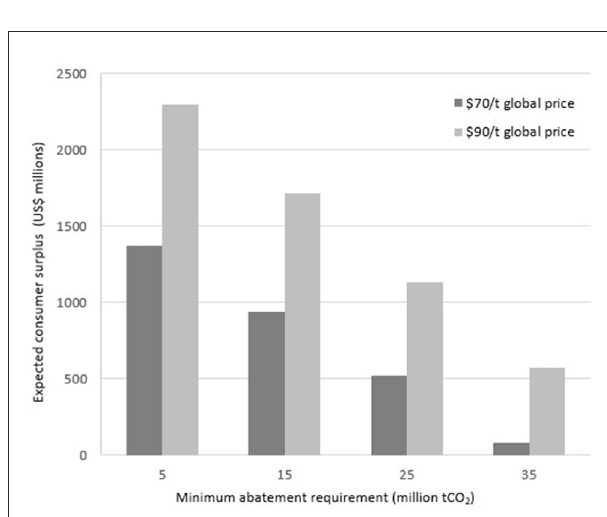
FIGURE7 Minimum abatement requirement and expected jurisdiction consumer surplus with insurance. Note: Vertical axis shows expected (probability-weighted) consumer surplus of jurisdiction. Assumed minimum abatement requirement ( Q ) varies as indicated across horizontal